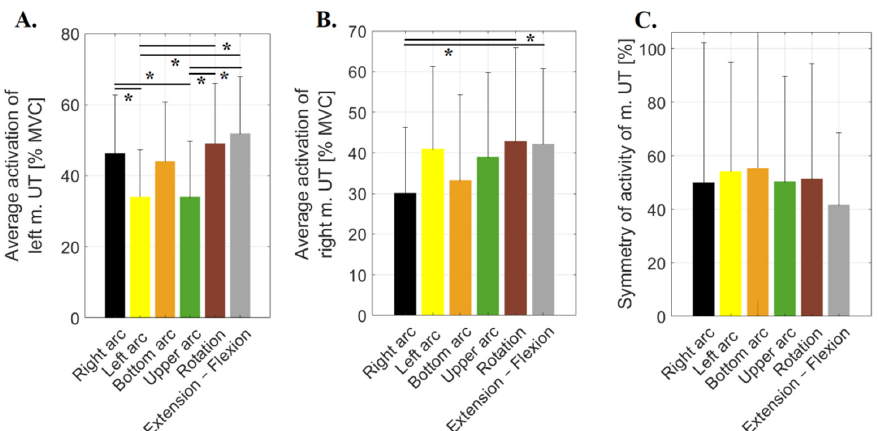
Figure 6. Average values of muscle activity recorded during six motions (right arc, left arc, bottom arc, upper arc, rotation and extension–flexion) for ( A )—left trapezius muscle (m. UT), ( B )—right trapezius muscle and ( C )—symmetry index calculated for trapezius muscle during the analysed motions; * p ≤ 0.05.